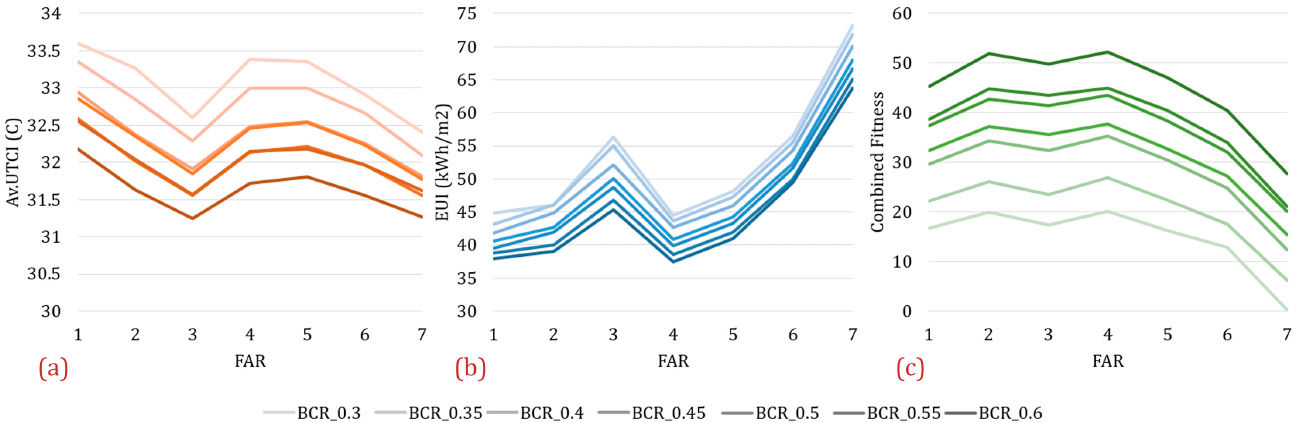
Figure 9. Relationship between FAR, BCR and performance indicators, ( a ) Av.UTCI, ( b ) EUI, and ( c ) combined fitness.